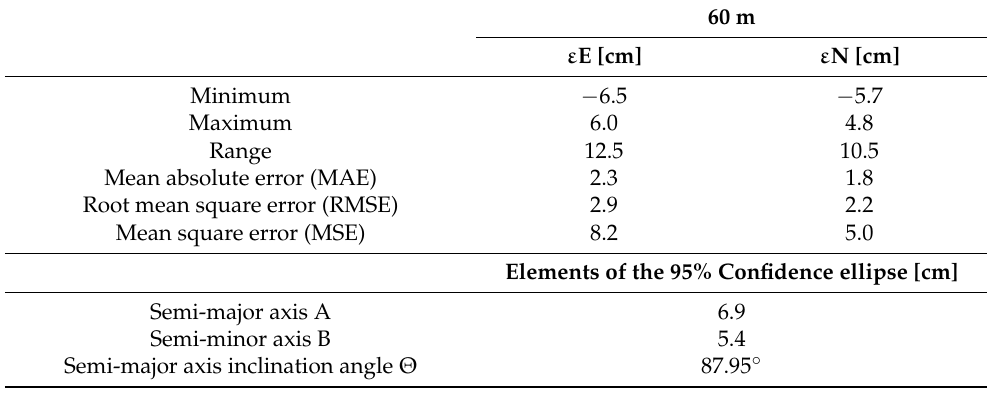
Table 11. UAS DJI Phantom 4 Pro V2.0—data quality with the use of GCPs.